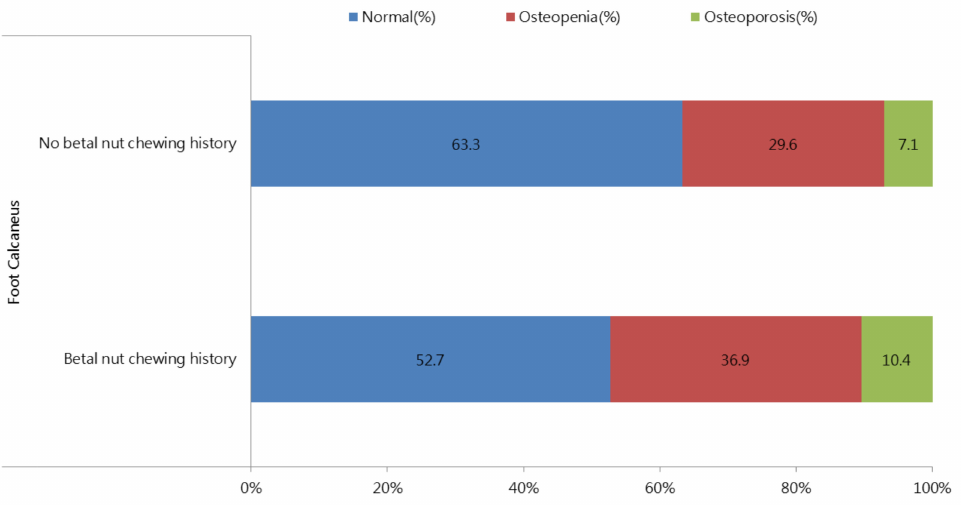
Figure 2. The distribution of calcaneus ultrasound T-score ≥ − 1.0, T-score − 1.0 to − 2.5 and T-score < − 2.5, stratified by the betel nut chewing history. There was a significant trend for an increase ( p < 0.001) in T-score < − 2.5 in participants with betel nut